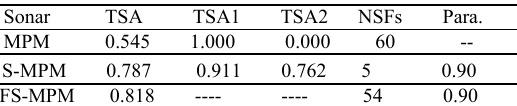
Table 1 TSAs and NSFs for Sonar .